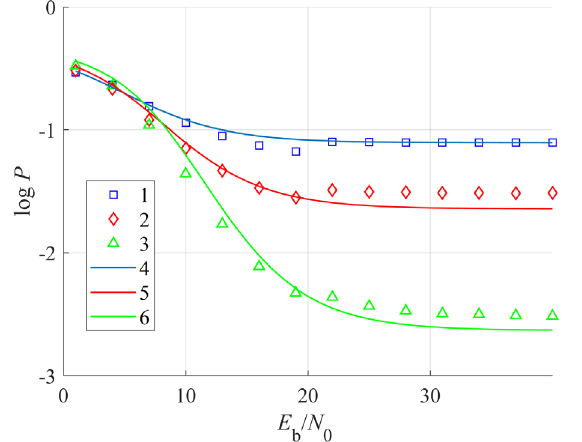
Figure 7. Bit error probability as a function of E b / N 0 obtained for the low values of the processing gain K (carrier signal with Gaussian distribution). Point series 1, 2, 3 correspond to the simulation results for values of K = 5; 10; 20 and solid curves 4, 5, 6—to the analytical estimates for values of K = 5; 10; 20, respectively.